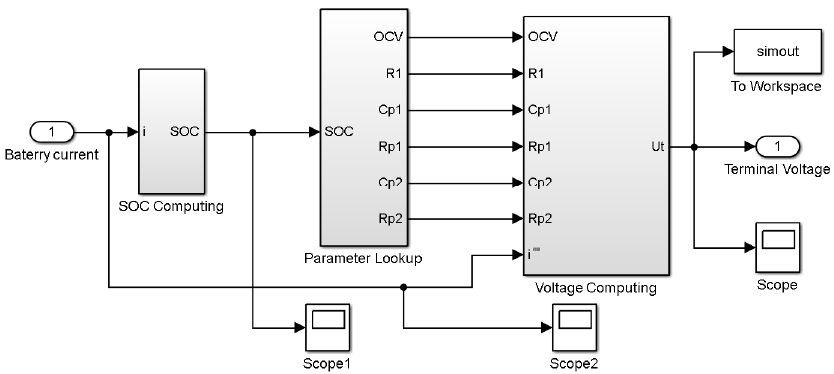
Figure 8. The simulation model of the second-order RC model for Simulink simulation.